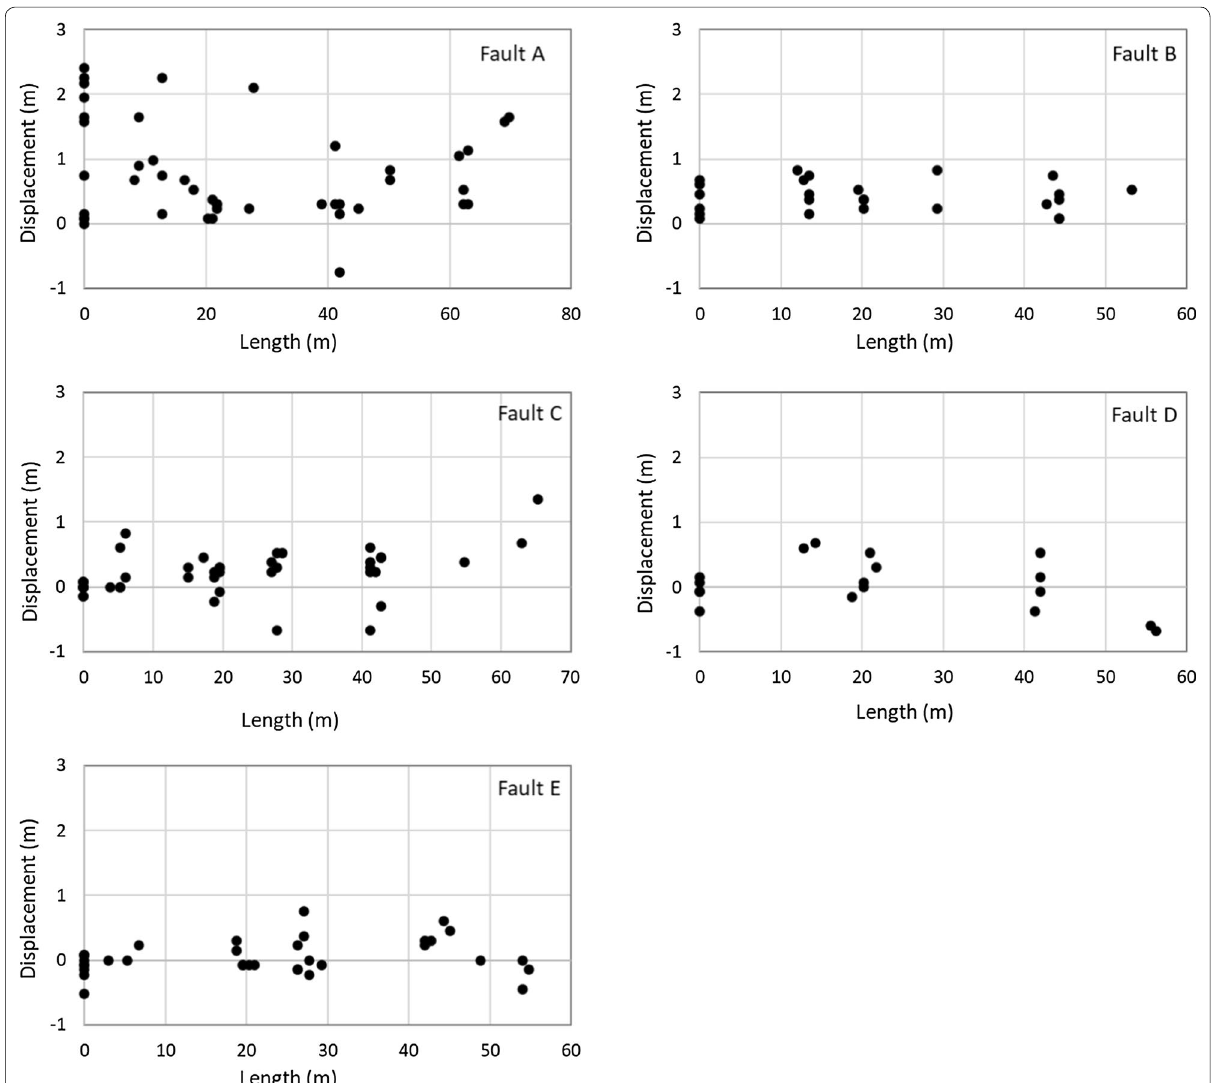
Fig. 4 Displacement versus length diagrams are shown for the faults interpreted from the MCS profiles. The conversion from two‑way travel time to depth to calculate the fault length was done using a constant velocity of 1500